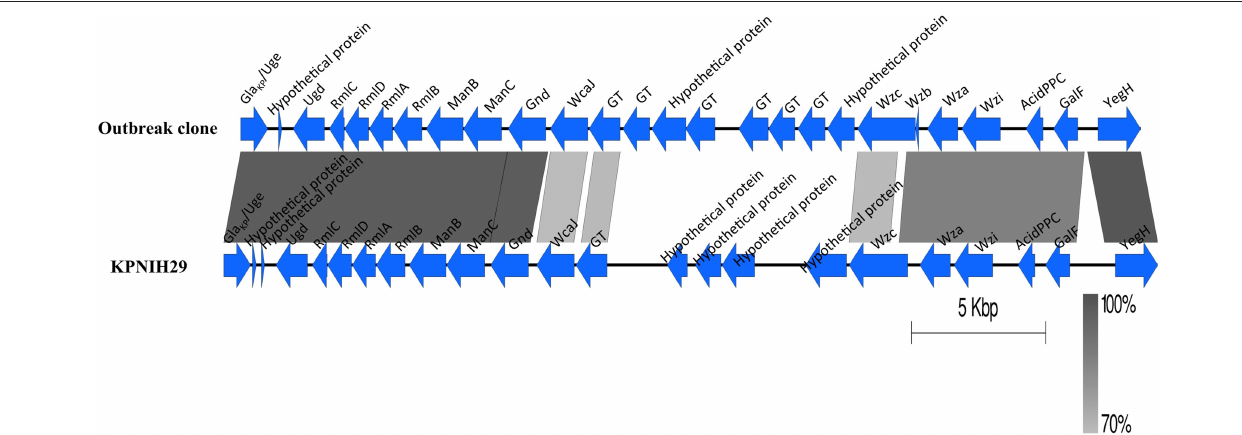
FIGURE 3 | Comparison of the capsular polysaccharide synthesis ( cps ) region. The cps region (including conserved flanking region) of K. pneumoniae KPNIH29 (GenBank accession number: CP009863) is retrieved from GenBank. The gradients (dark to pale) of the alignment region represent the percentage of sequence identity between samples as defined by BLASTn. GT represents